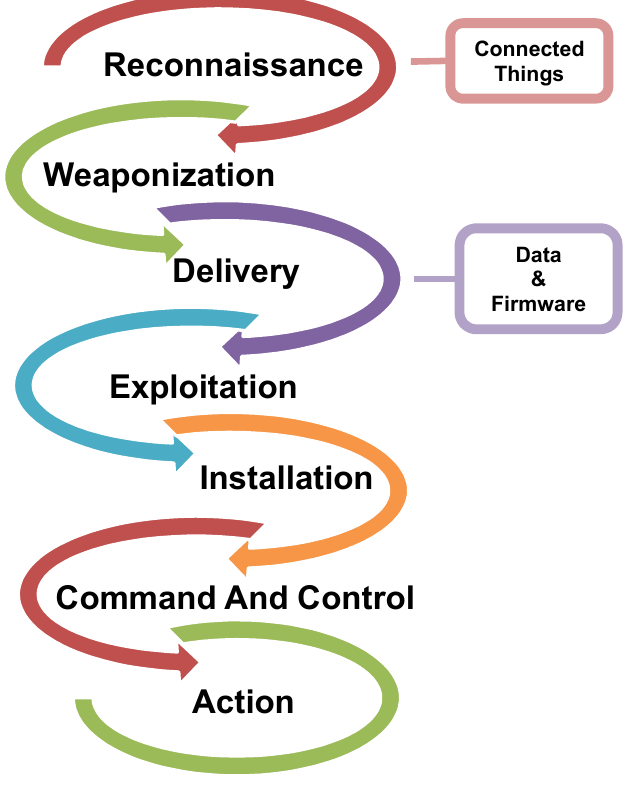
Figure 3. APT Attack phases in